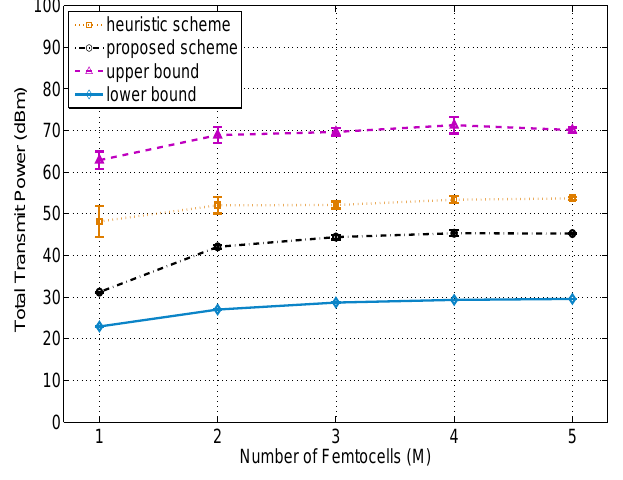
Figure 6. Total power vs. number of